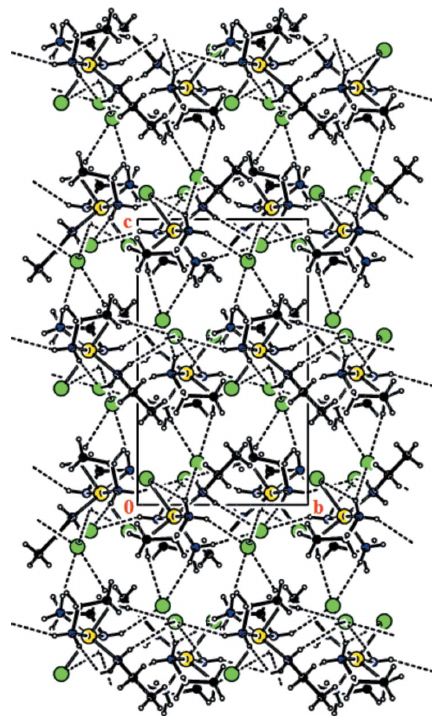
Figure 3 A packing view of the title compound down the a axis. Intermolecular contacts involving the Br ions are represented with dashed bonds.